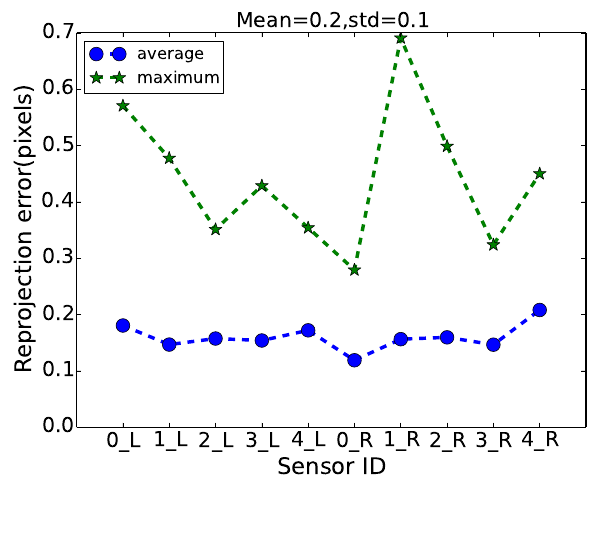
Figure 6. Reprojection error for each visual